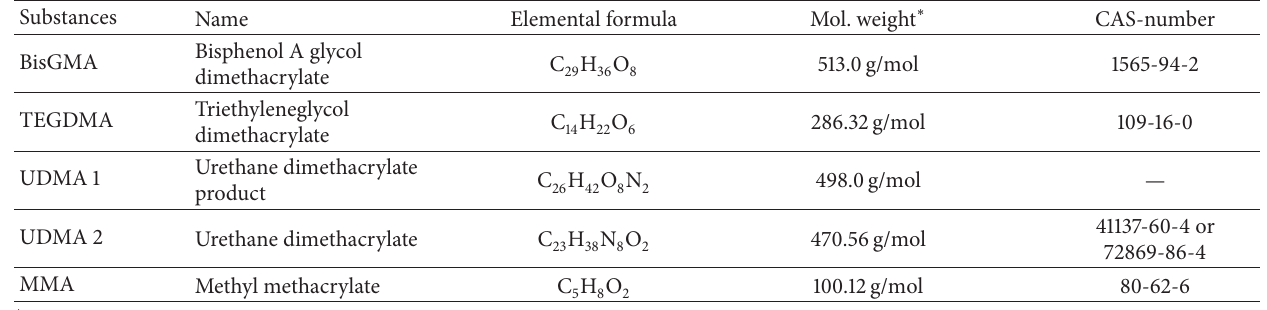
Table 2: Monomers used as reference standards.